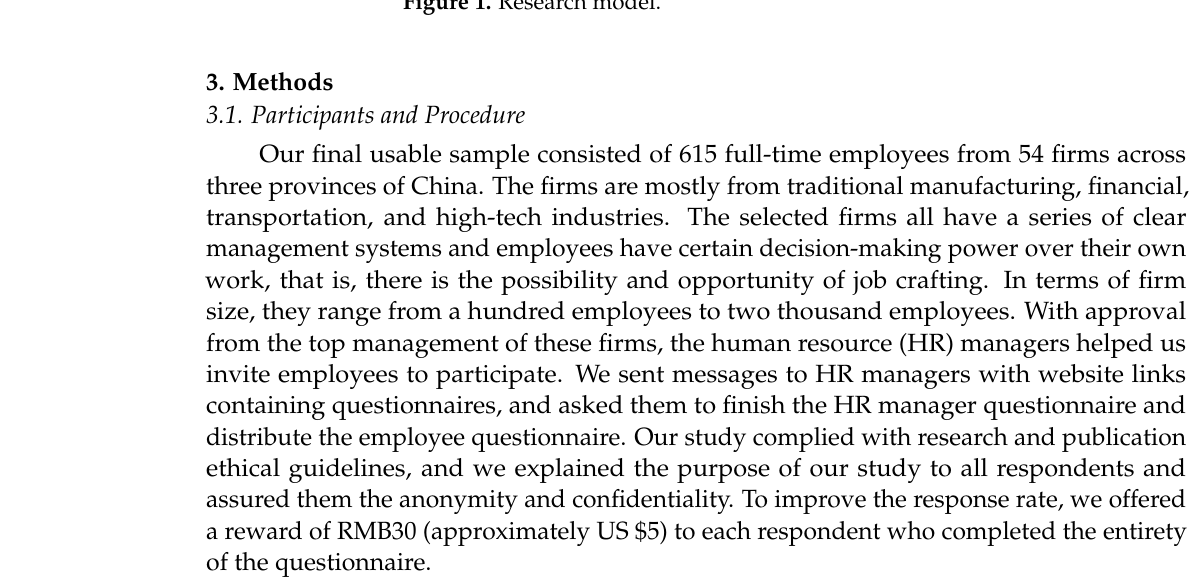
Figure 1. Research model.